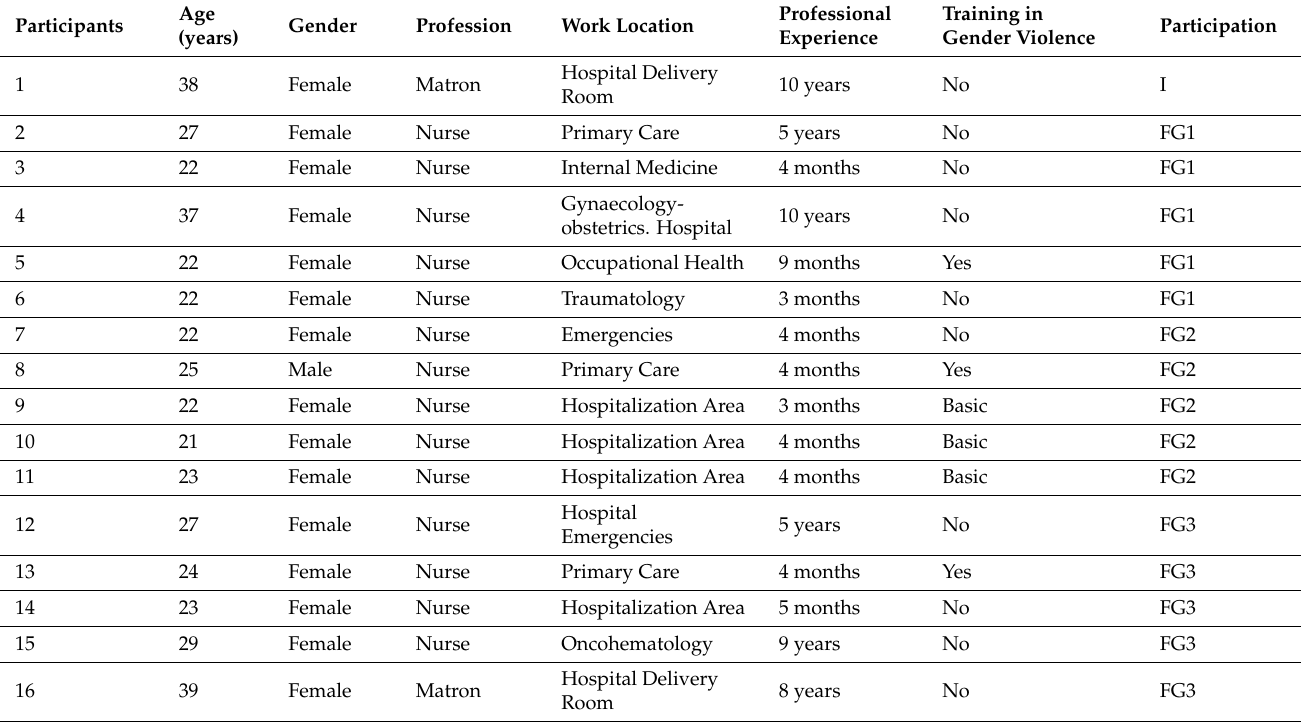
Table 1. Sociodemographic data of the